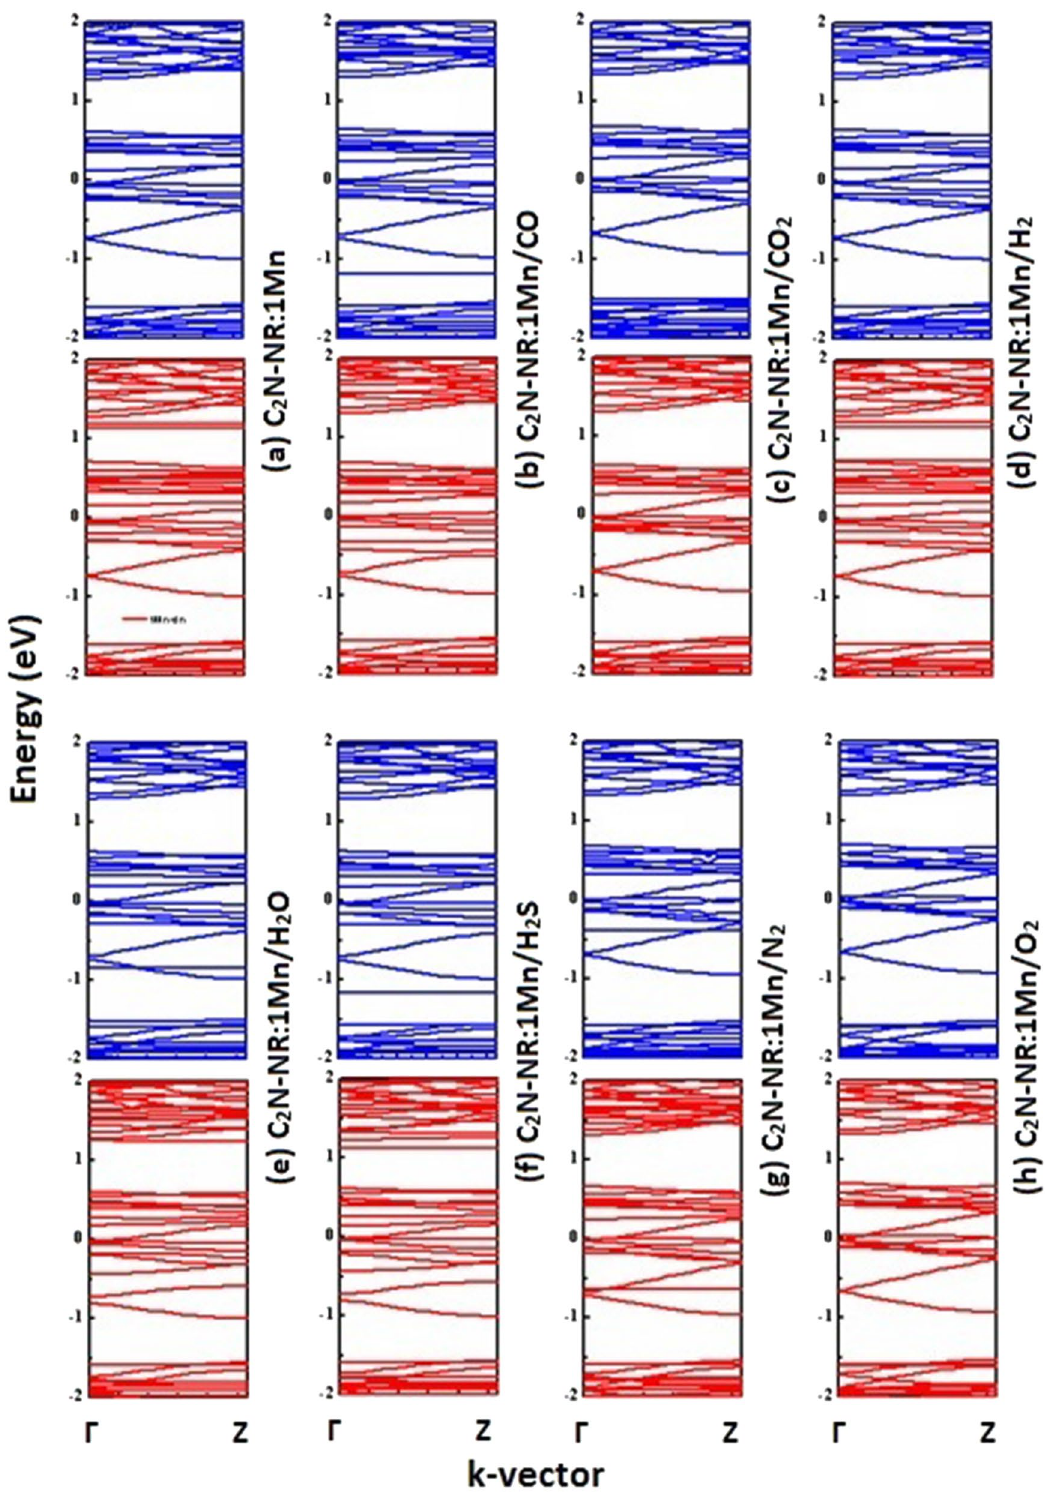
Figure. 2. Electronic band structures of C 2 N-NR:1Mn after adsorption of various gas molecules. Spin-up (down) bands are shown by blue (red)